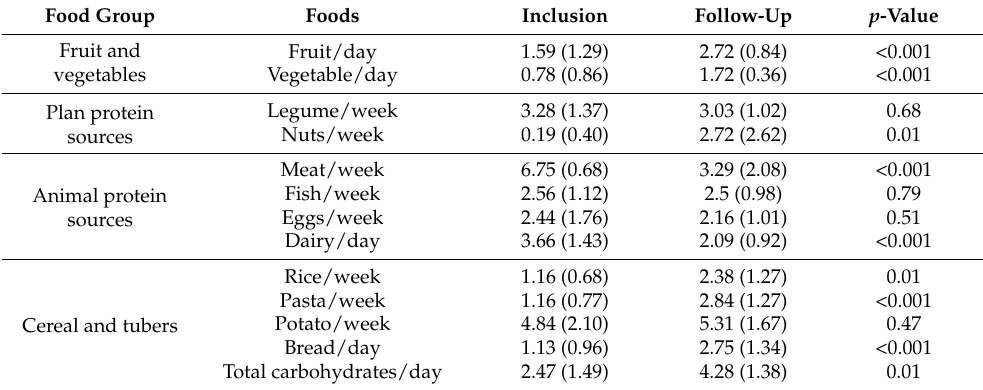
Table 4. Frequency of consumption frequency of type of food at the beginning and last follow up after nutrition